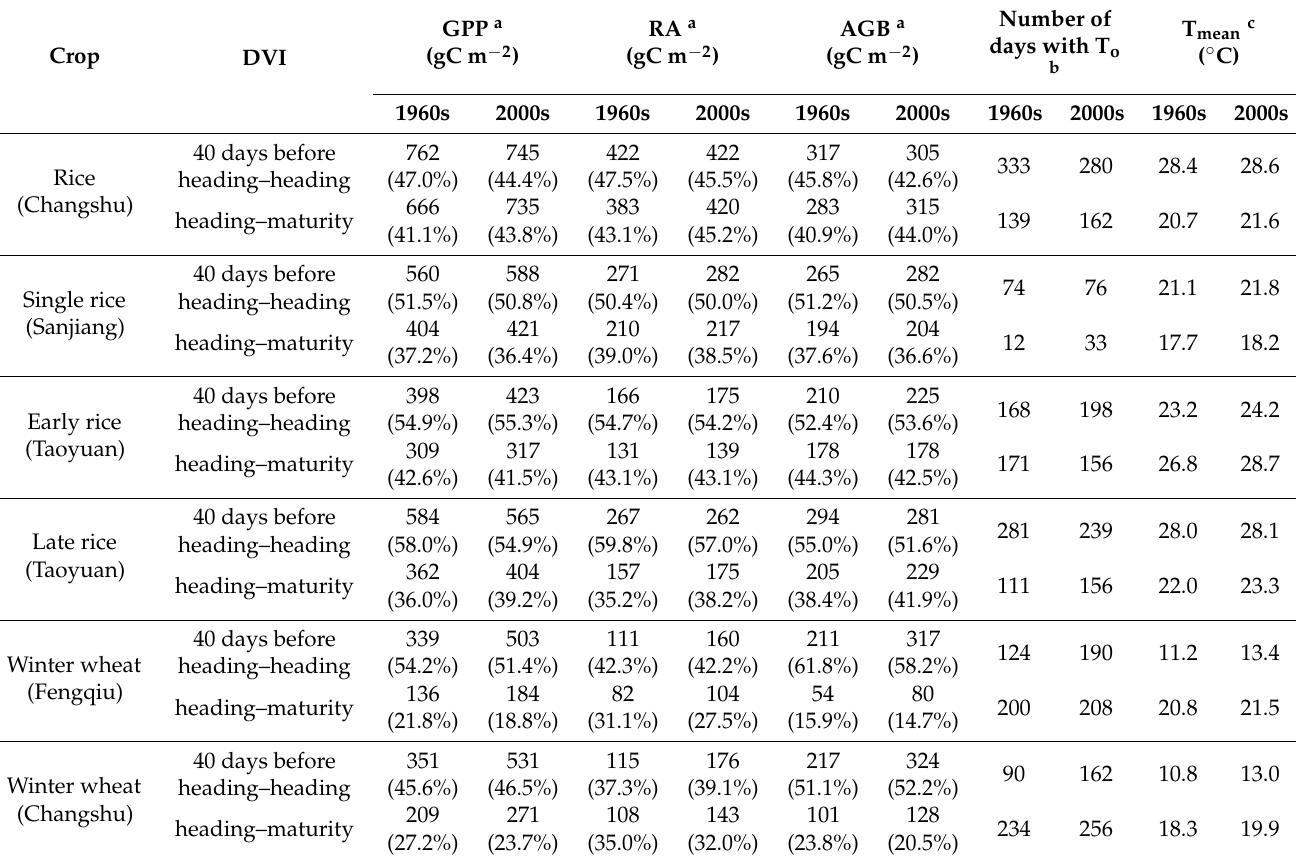
Table 4. Photosynthetic production and temperature changes in different growth periods for the 1960s and 2000s.